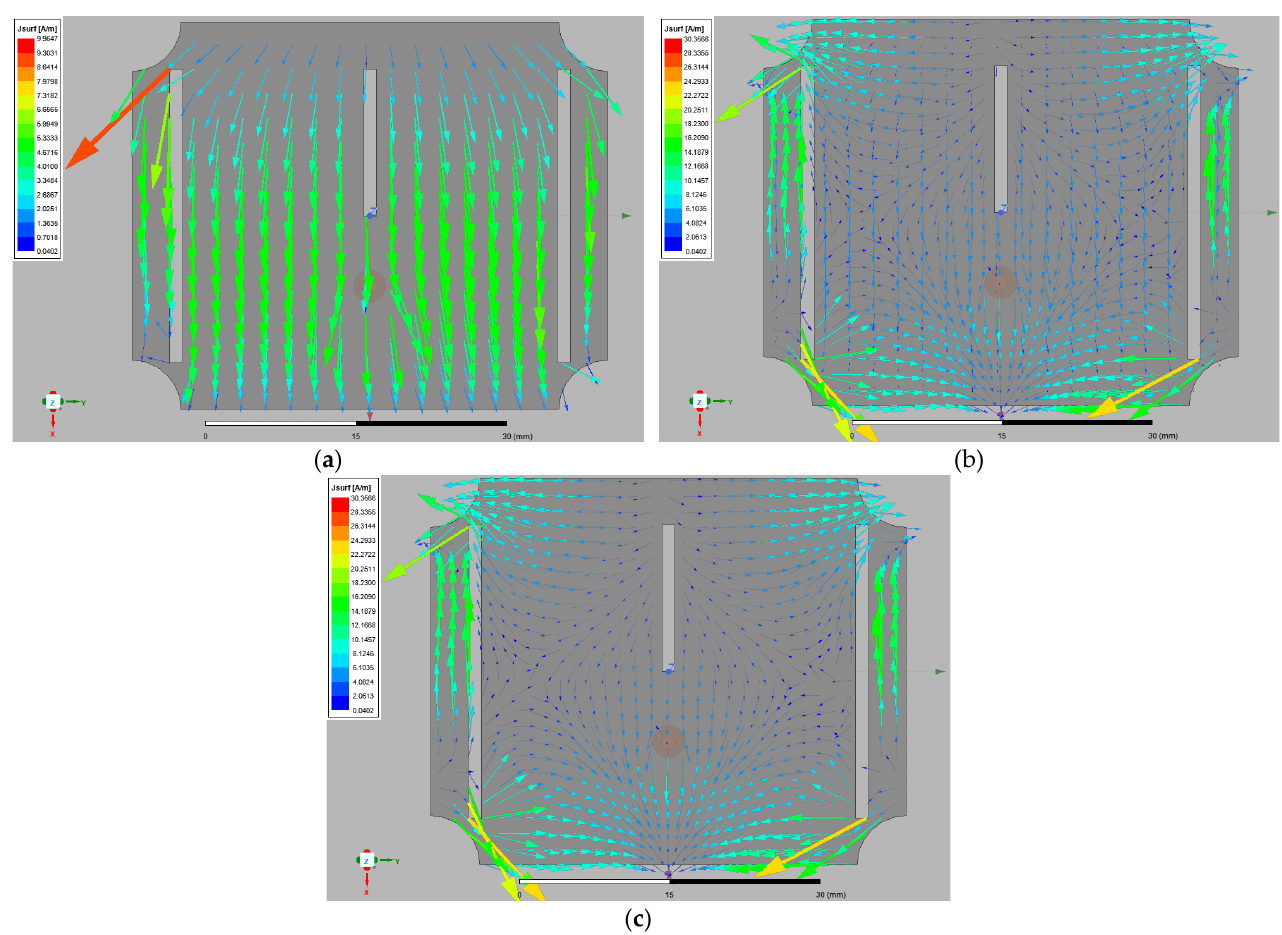
Figure 7. Current distributions at the surface of MPATSAT: ( a ) for 2.45 GHz; ( b ) for 4.73 GHz; ( c ) for 5.21 GHz.